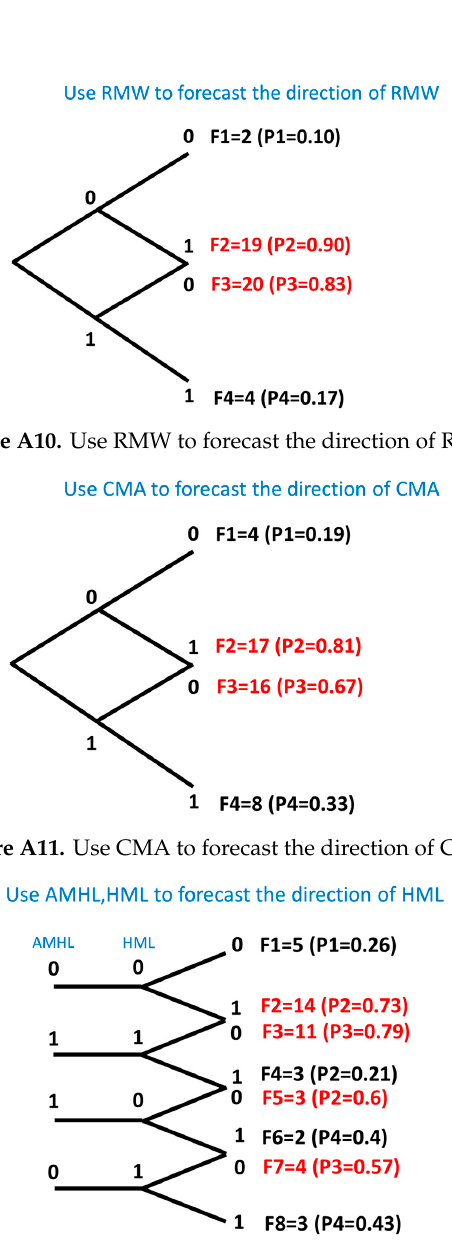
Figure A12. Use AMLH and HML to forecast the direction of HML.